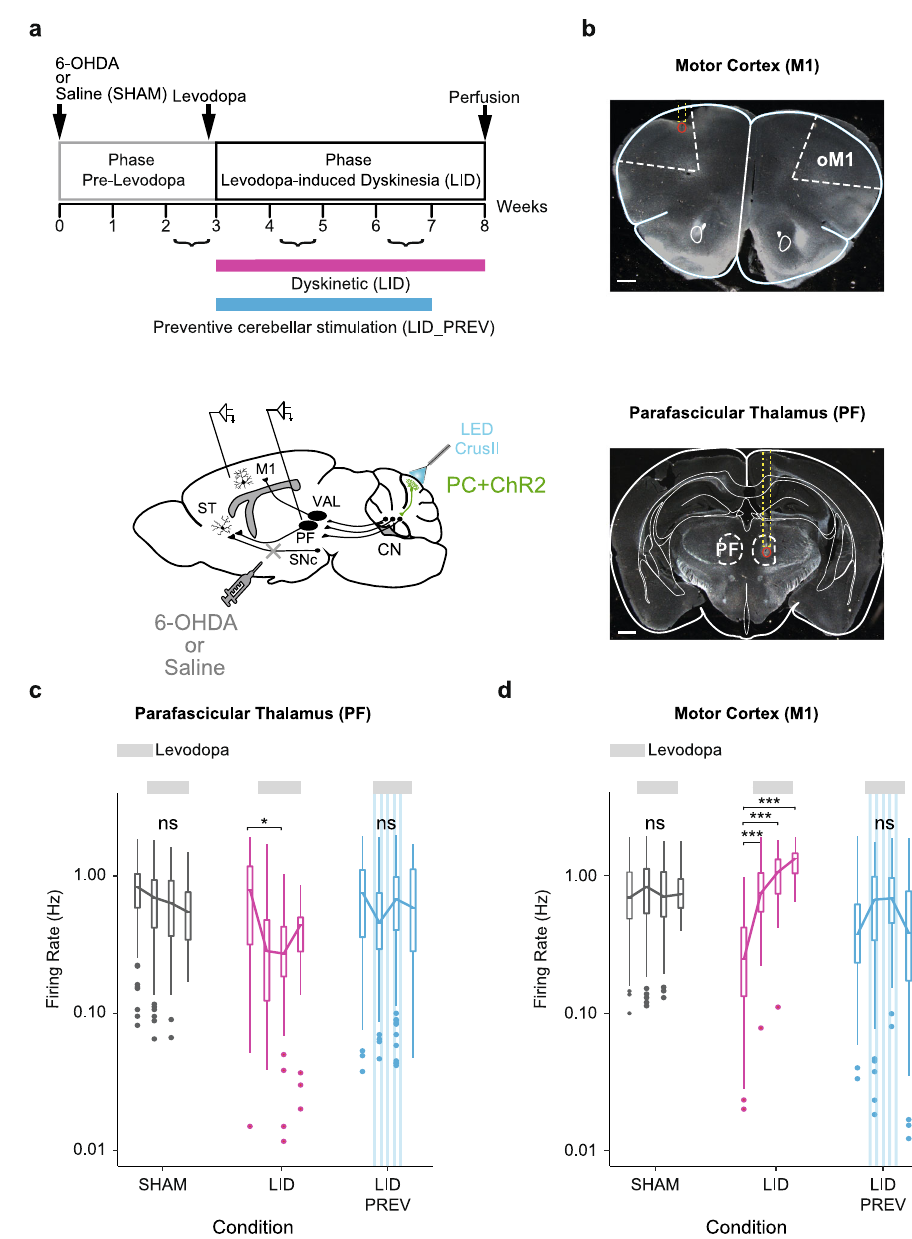
Fig. 3 Aberrant activities in the motor cortex and the parafascicular nucleus of the thalamus in dyskinesia are restored by Purkinje cell stimulation. a Top : Experimental timeline. Bottom : Schematic of electrode implantation in the primary motor cortex (M1) and the parafascicular nucleus of the thalamus (PF), ChR2-YFP expression in the Purkinje cells (PC + ChR2, green), and injection site of 6-OHDA or saline. ST: Striatum; SNc: substantia nigra pars compacta ; CN: cerebellar nuclei: VAL: Ventroanterior-ventrolateral complex of the thalamus. b Top: Coronal section from L7-ChR2-YFP mouse showing the electrode ’ s trajectory (dotted yellow line) and the lesion site (red circle) in layer 5 of oM1. Scale bar: 0.5 mm. Bottom: Coronal section from L7-ChR2-YFP mouse showing the electrode ’ s trajectory (dotted yellow line) and the lesion site (red circle) in PF. Scale bar: 0.5 mm. c Firing rate (Hz) across 9 weeks in M1. Boxplots show the median rate (horizontal bars), over 4 categories of weeks. First boxplot: 2nd and 3rd week of the protocol, second boxplot: 4th and 5th weeks when levodopa begins, third boxplot: 6th and 7th weeks, last boxplot: 8th of the protocol when stimulation stopped. Gray = SHAM ( N = 5); Magenta = LID ( N = 4); Blue = LID_PREV ( N = 8). Light gray lines: 6 weeks of levodopa treatment (3 boxplots; 6 mg/kg). Stripped blue lines: weeks of theta-burst stimulation. d Firing rate (Hz) across 9 weeks in PF. Same order of boxplot as panel c Gray = SHAM ( N = 5); Magenta = LID ( N = 4); Blue = LID_PREV ( N = 8). Light gray lines: 6 weeks of levodopa treatment (3 boxplots; 6 mg/kg). Stripped blue lines: weeks of theta-burst stimulation. Boxplot represents the lower and the upper quartiles as well as the median of the fi ring rate (horizontal bars). Vertical lines represent the median ± std. Isolated points represent outliers of the distribution. One-way Anova with two-sided Tukey HSD post-hoc test. *** p < 0.001; ** p < 0.01; * p < 0.05; ns: p > 0.5. Source data are provided as a Source Data fi le. See also Tables S8 and S9.